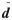
Parametric diagrams of blood coagulation regimes in the (h, Re) parameter space for two different values of d~, the non-dimensional plaque diameter.Region “I” denotes regimes in which there is no coagulation, region “II” represents regimes of macroscopic thrombus formation. (a): d~=0.3, μ~2=7; (b): d~=0.5, μ~2=7.